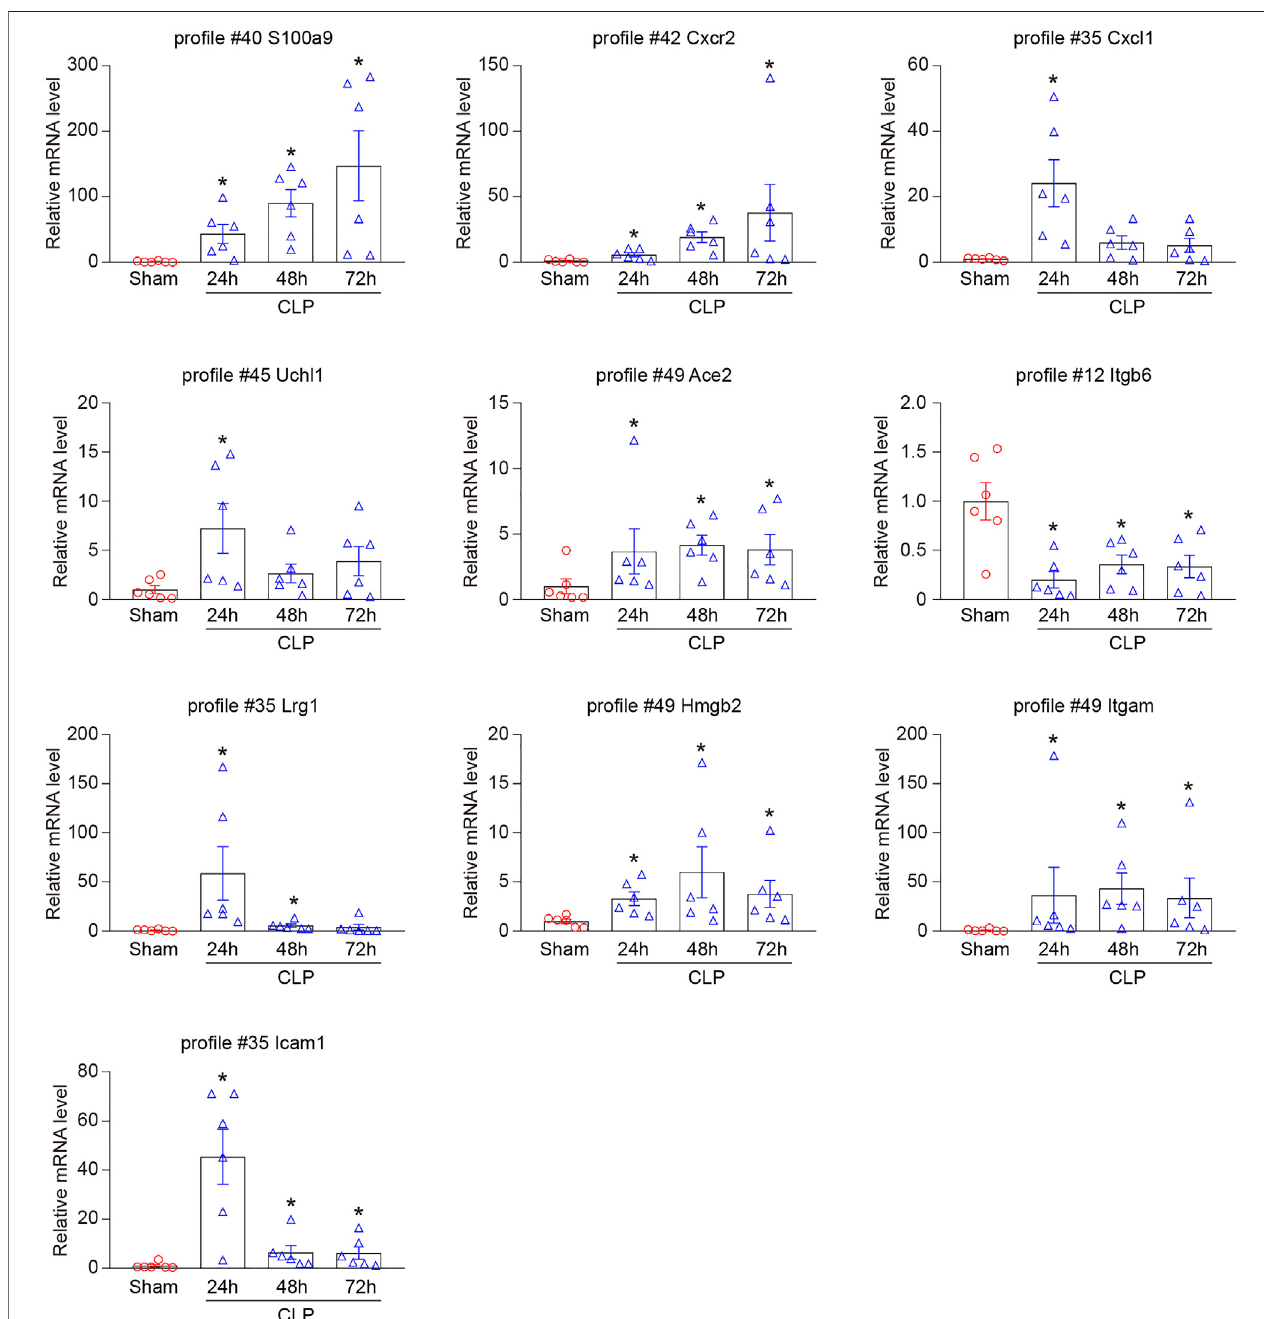
FIGURE5| Veri fi cation oftheselectedDEGsinRNAsequencing results.qPCRanalysesofthemRNAexpression levelof10DEGsinheartsafter CLPoperationat different time points (n = 6 per group), including S100a9 (pro fi le #40), Cxcr2 (pro fi le #42), Cxcl1 (pro fi le #35), Uchl1 (pro fi le #45), Ace2 (pro fi le #49), Itgb6 (pro fi le #12), Lrg1 (pro fi le #35), Hmgb2 (pro fi le #49), Itgam (pro fi le #49), and Icam-1 (pro fi le #35). GAPDH as an internal control. The signi fi cance of difference between the means of groups was evaluated using One-way ANOVA following Newman-Keuls multiple comparison test. * p < 0.05 versus sham control.